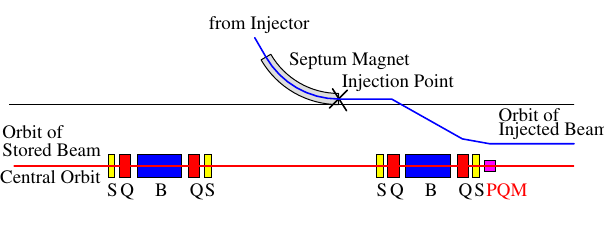
FIG. 2. (Color) Same as Fig. 1, but the injection scheme is using the PQM instead of the four kicker magnets. The injected beam is perturbed by the PQM; it then oscillates with a large amplitude in the ring. The stored beam passes through the central position of the PQM and its orbit is preserved on a central